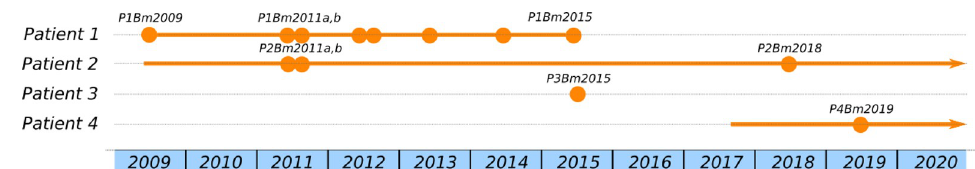
Fig 1. Timeline of B . multivorans ST-742 isolations from sputum samples in Patients 1 to 4. Each dot represents an isolate (exact isolation dates in Table 1). The 2011 and 2012 isolates of patient 1 and 2012 isolates of patient 2 each originated from the same sputum sample and were studied in parallel as they displayed distinct colony morphologies. The line connecting the isolates indicates the infection timeline, with the infections of patients 2 and 4 still currently ongoing.